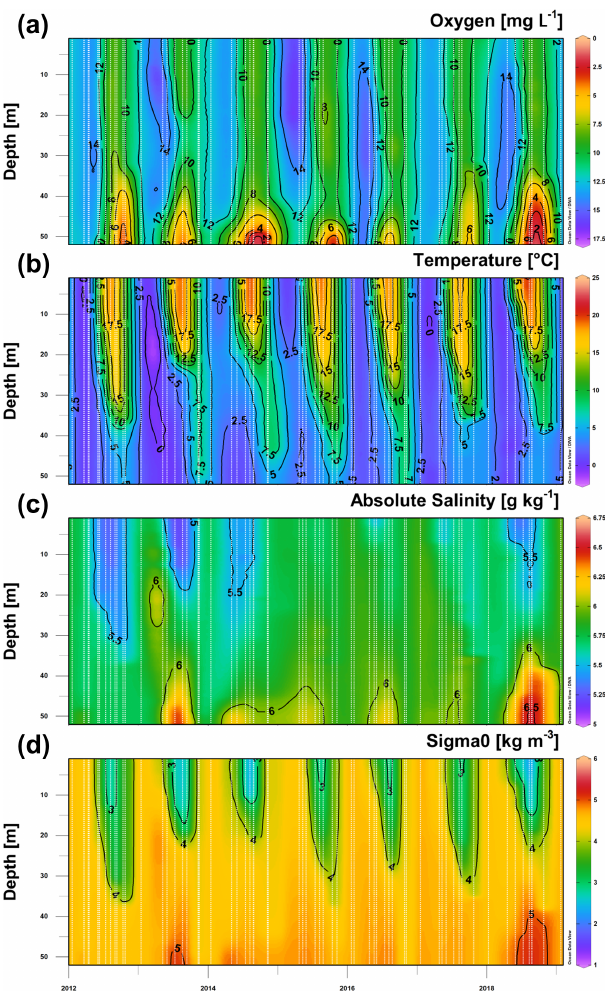
Figure 4. Vertical profiles of dissolved oxygen concentration (a,e) , temperature (b,f) , salinity (c,g) , and density anomaly (d,h) mea- sured in the Ruhnu Deep (station G1; see location in Fig. 1) in 2017 (a–d) and 2018 (e–h)